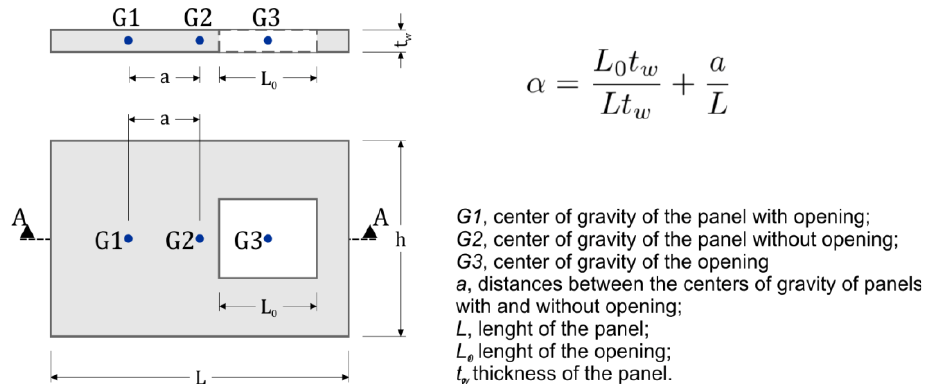
Figure 2. Opening parameter α for t he method proposed by Saheb and Desayi